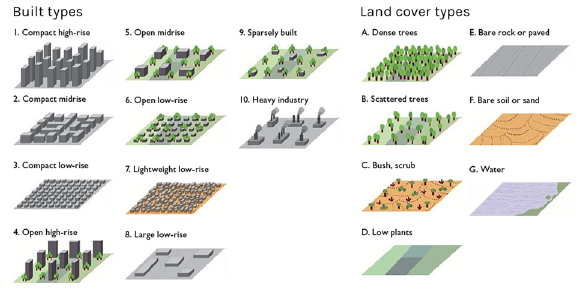
Figure 1. Local climate zones classifications, based on Stewart and Oke (2012).